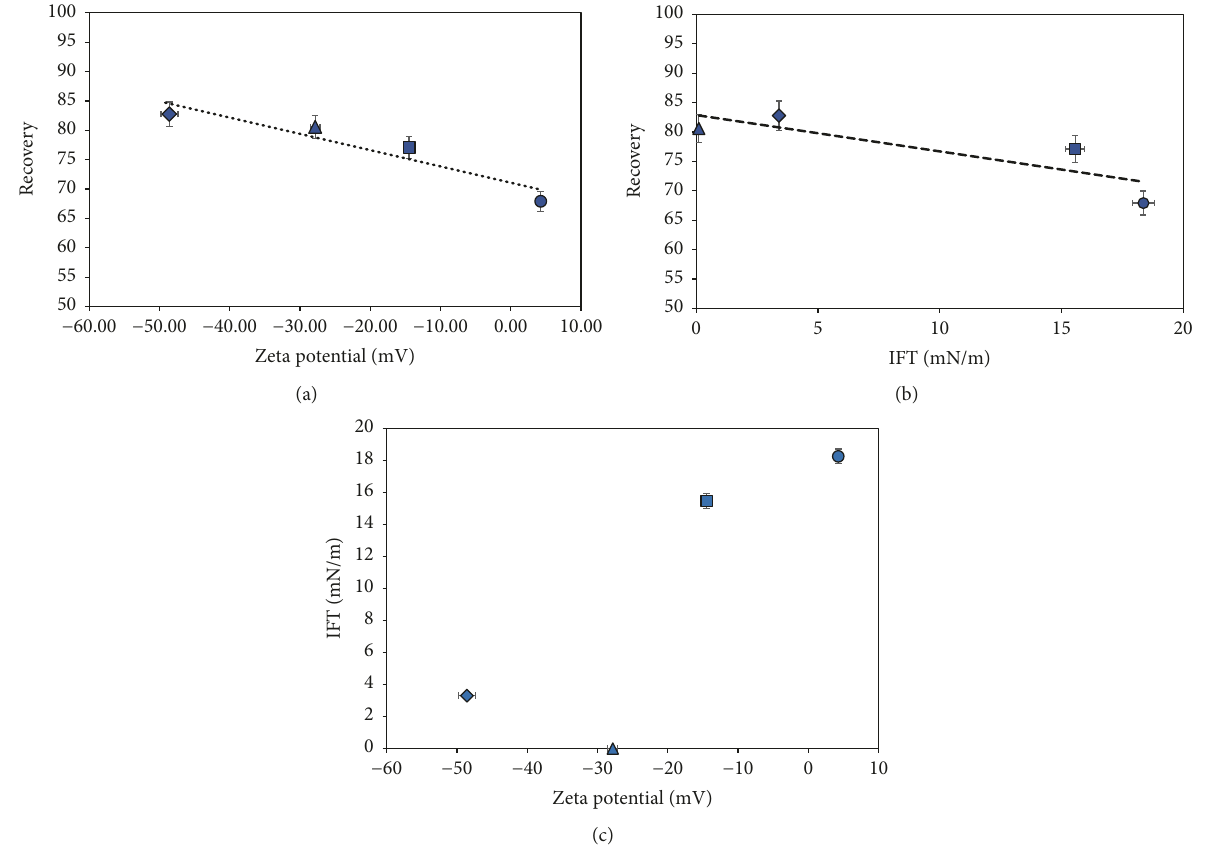
Figure 9: Correlation between continuous secondary recovery and (a) zeta potential; (b) correlation between recovery and IFT during FMB (circle), CSB (square), CSBS-G (rhombus), and CSBS-R (triangle) flooding. (c) Relationship between interfacial tension and zeta potential during FMB (circle), CSB (square), CSB-R (triangle), and CSB-G (rhombus)